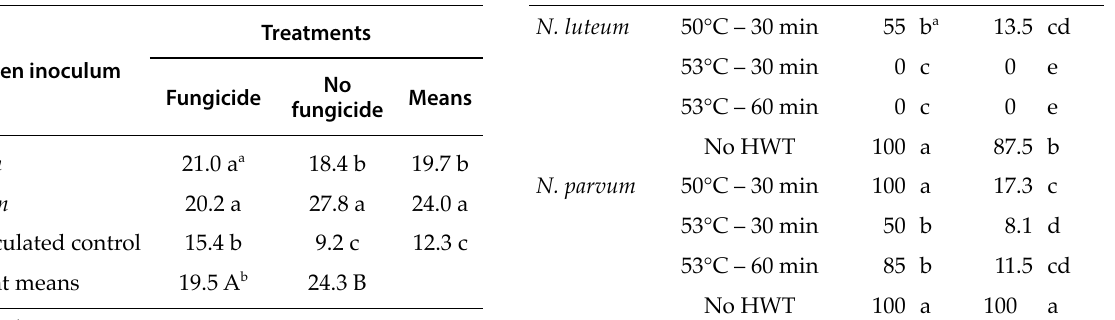
a Means within a column. b Means within the final row which have different letters are sig- nificantly different according to Fisher’s LSD at P ≤0.05